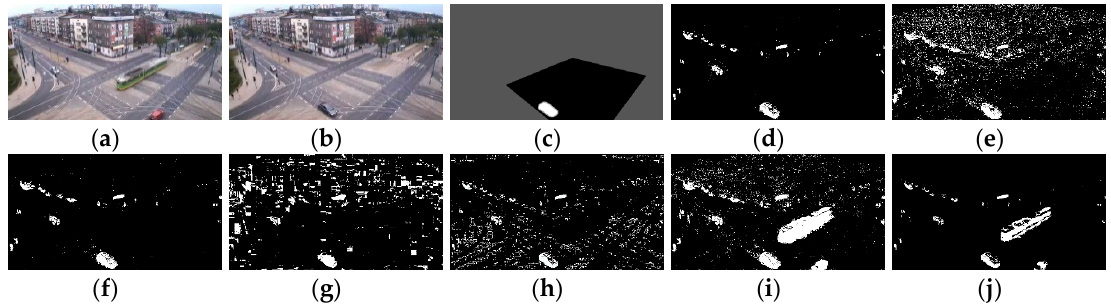
Figure 10. Comparison of segmentation results of seven background subtraction methods for one frame taken from the tramCrossroad_1fps sequence. ( a ) Frame n (start image), ( b ) frame n + 99, ( c ) ground ‐ truth, ( d ) EBBE (proposed), ( e ) codebook, ( f ) GMM, ( g ) KDE, ( h ) PBBE, ( i ) SOBS, and ( j ) ViBe.